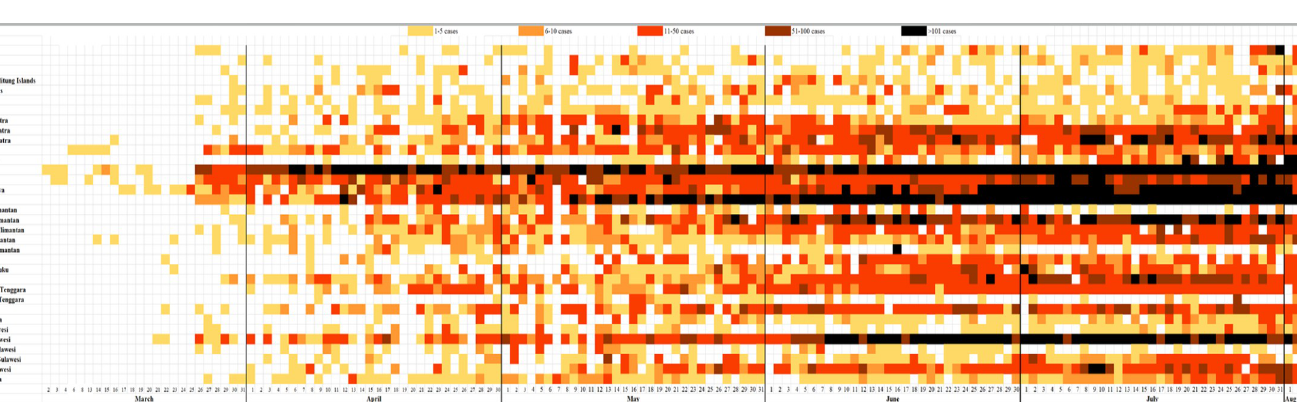
PLOS ONE | https://doi.org/10.1371/journal.pone.0243703 December22,